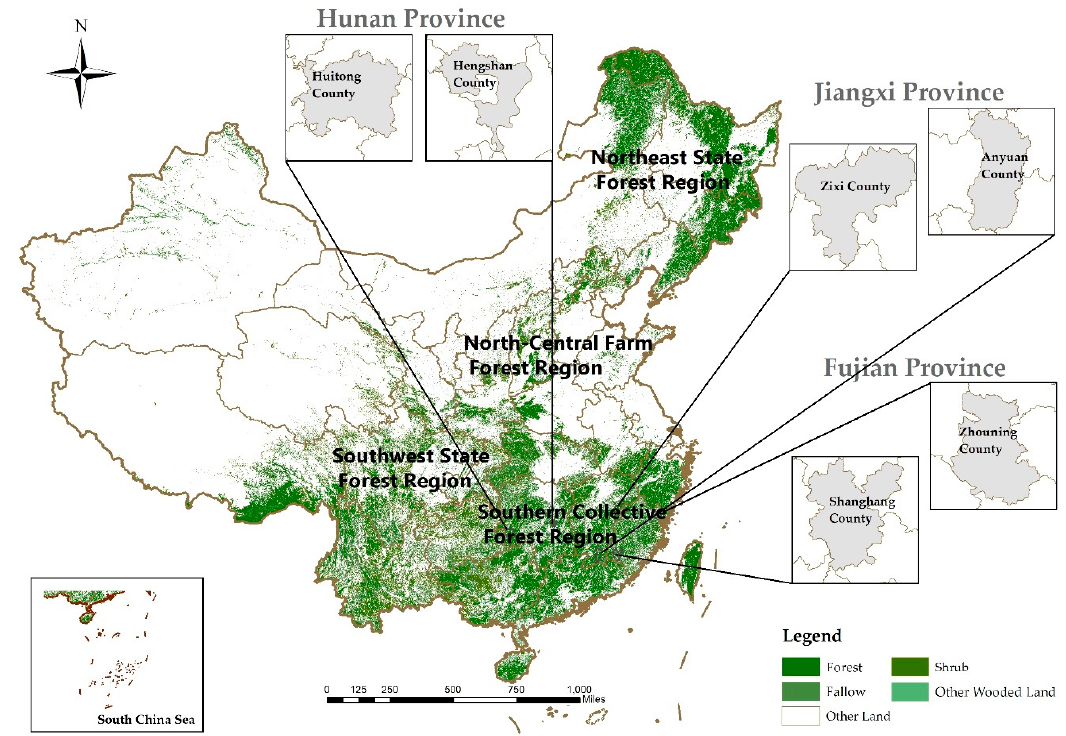
Figure 1. Forest distribution of China and data collection areas.